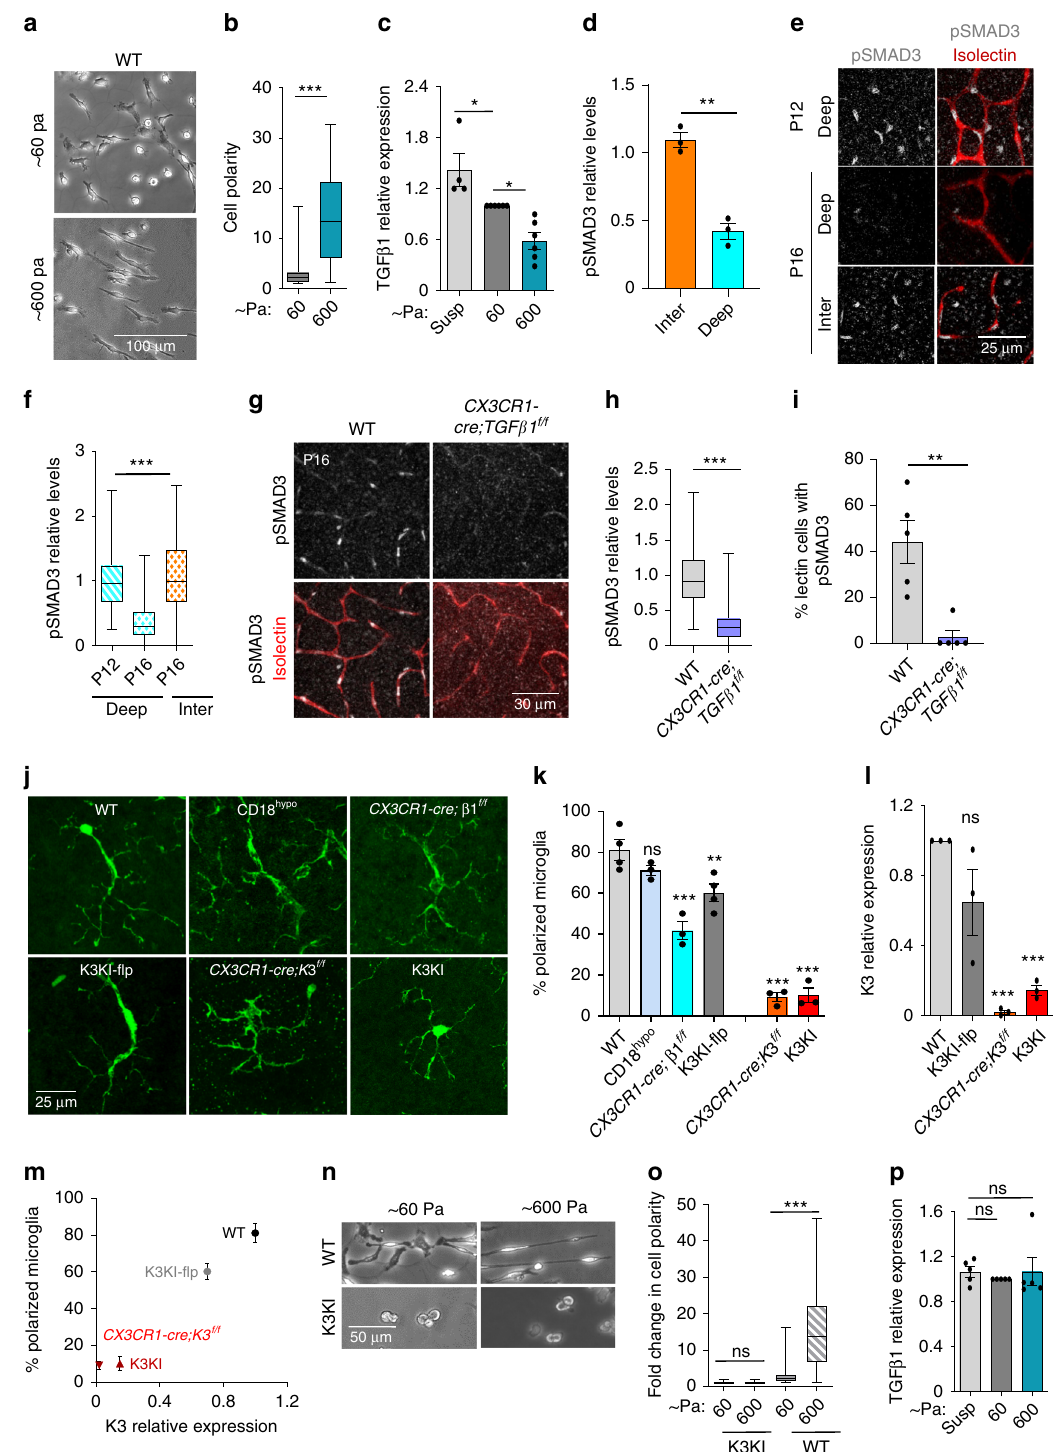
retinas from CX3CR1-cre;K3 f/f and control mice, which revealed changes in ~140 genes, primarily re fl ecting the main cellular component of retinas, the photoreceptors (supplementary fi